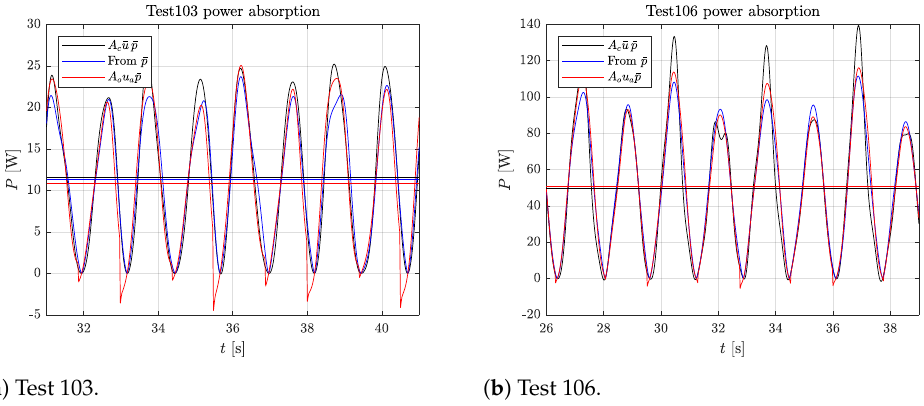
Figure 11. Estimates of the measured power absorption computed from the product of the measured pressure and each of the flux estimates shown in Figure 10, i.e., based on each of the three measured quantities: ¯ η , ¯ p , and ¯ u a . The horizontal lines indicate the mean power absorption per wave